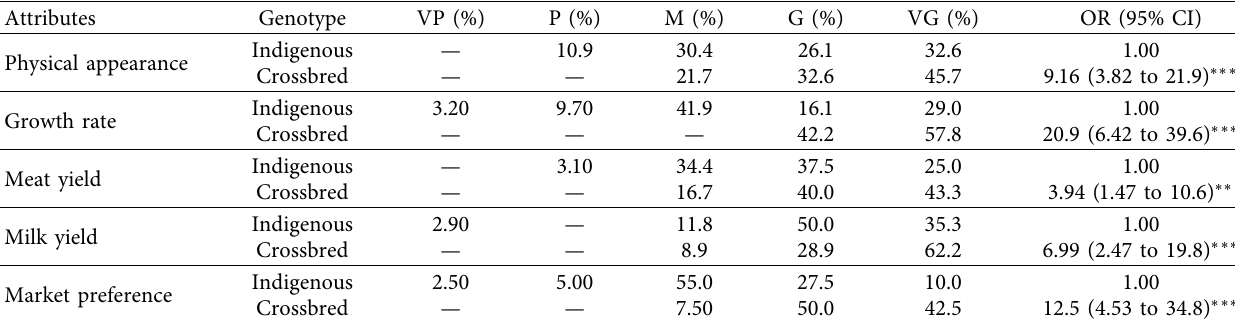
Table 4: Odds ratio estimates of the productive attributes (crossbred vs indigenous